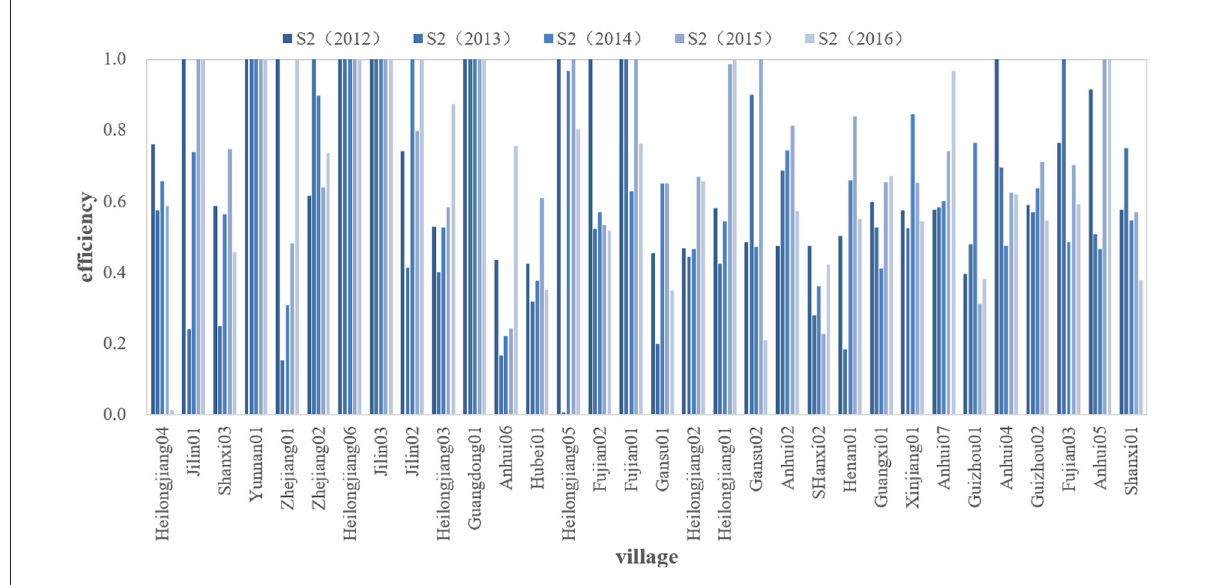
FIGURE5 Social governance efficiency in the second stage, from 2012 to